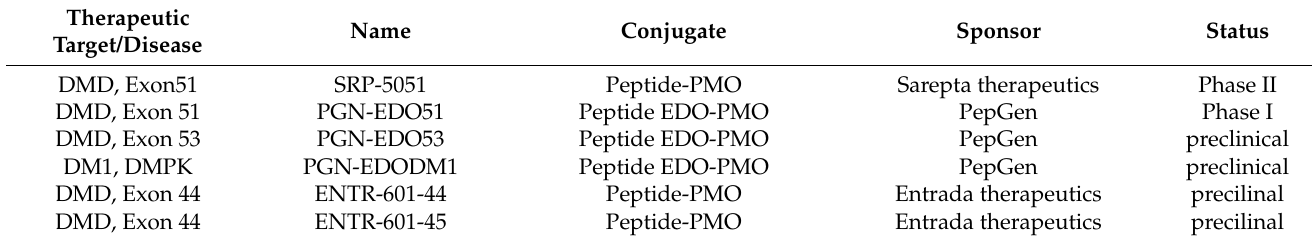
Table 2. Oligonucleotide conjugates in recent advanced preclinical and clinical studies. Therapeutic